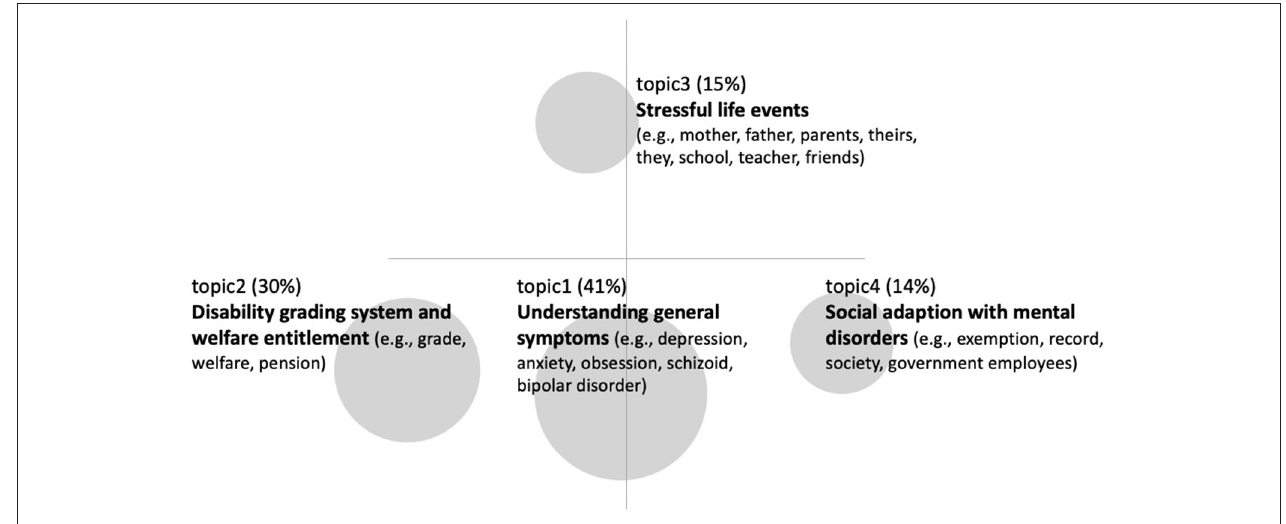
FIGURE 3 | Inter-topic distance map in the LDA